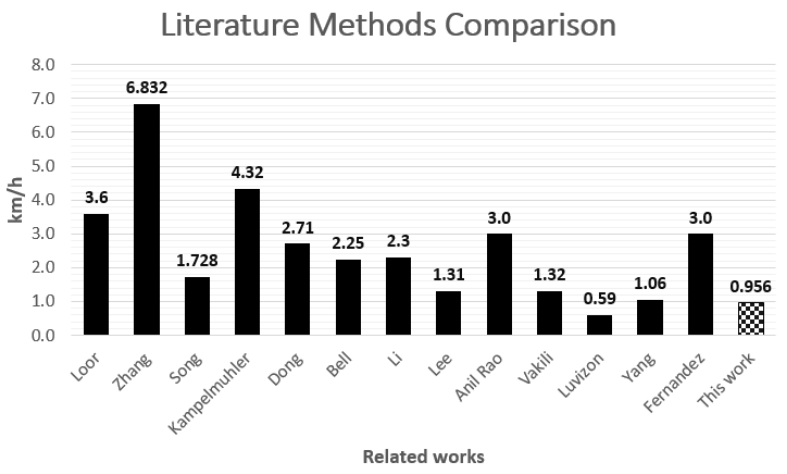
Figure 13. Methods